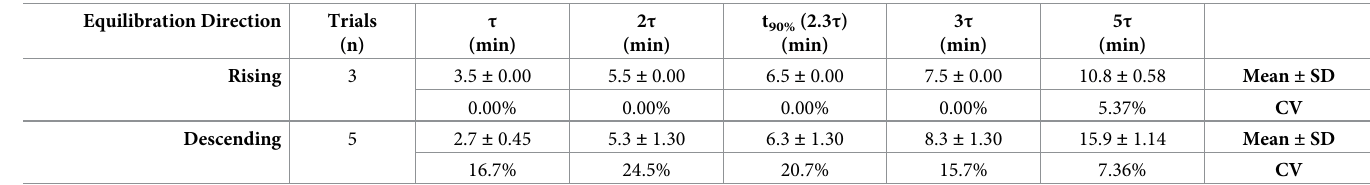
Table 2. Summary of time constant, τ , for rising and falling